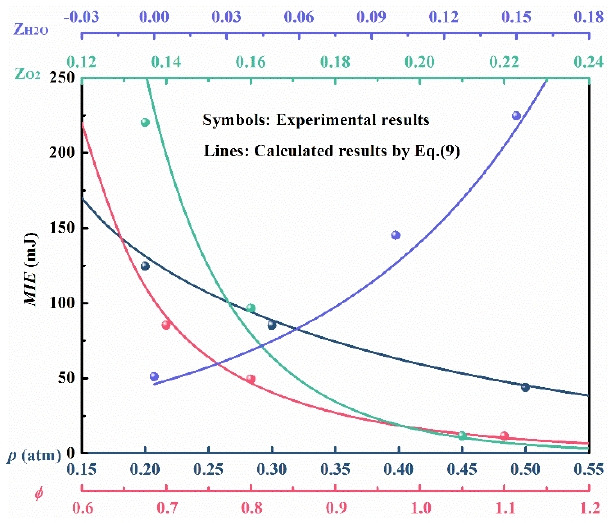
Figure 10. Comparison between the calculated results and the experimental results of MIE.